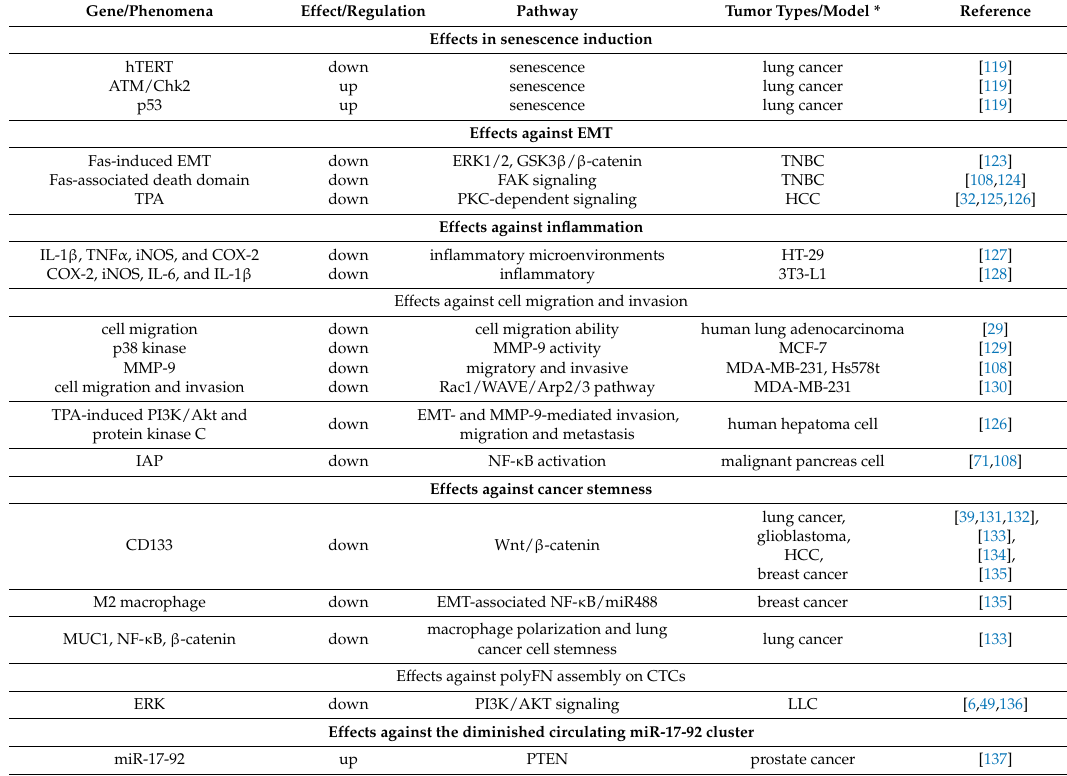
Table 2. Summary of nonapoptotic effects of PS against